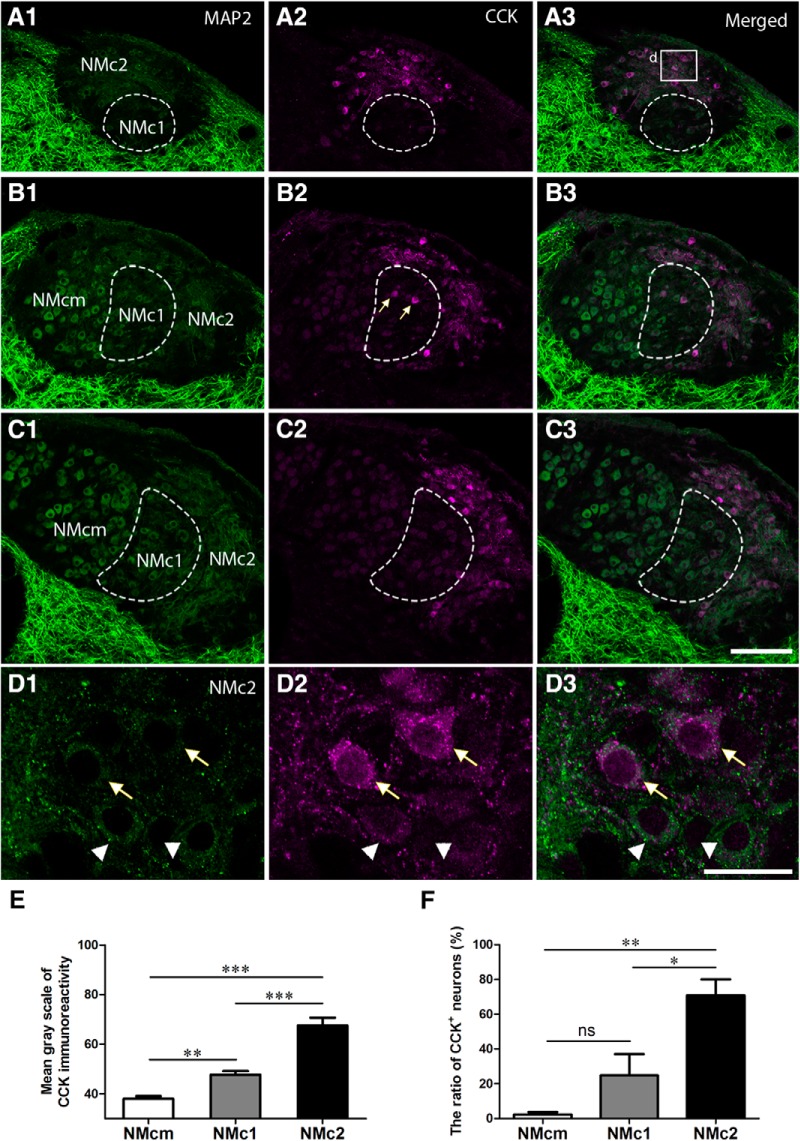
CCK is a biomarker for NMc2. The left (A1, B1, C1, D1) and middle (A2, B2, C2, D2) columns are MAP2 and CCK immunostaining, respectively. The right column (A3, B3, C3, D3) shows the merged images. A–C, Low-magnification images were taken from sections located caudal to rostral from the same animal. Dashed lines outline NMc1. Arrows in B2 indicate CCK-positive neurons in NMc1. D, High-magnification images of the box in A3. Arrows and arrowheads indicate darkly and lightly CCK-labeled NMc2 neurons, respectively. E, Bar chart of the mean grayscale of CCK-expressing neurons in NMcm, NMc1, and NMc2. F, Bar chart of the percentage of CCK-immunoreactive neurons in NMcm, NMc1, and NMc2. *, P < 0.05; **, P < 0.01; ***, P < 0.001; ns, not significant. Data are presented as mean ± SD. Abbreviations: see Fig. 1. Scale bars = 100 μm in C3 (applies to A1–C3) and 20 μm in D3 (applies to D1–D3).